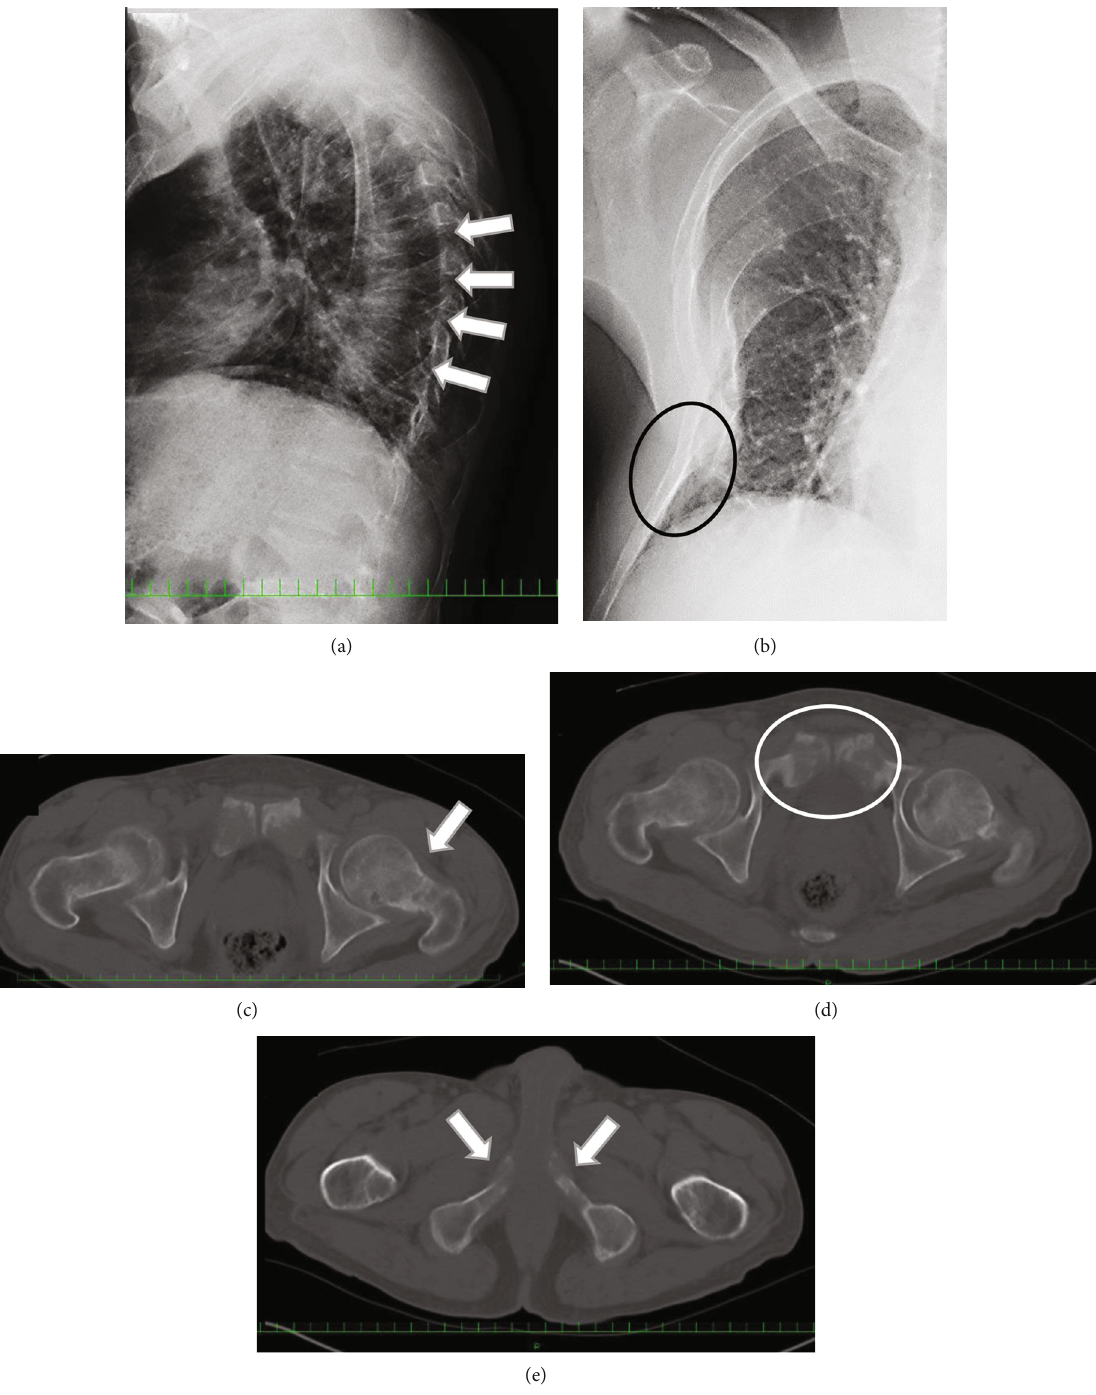
Figure 1: Radiographs taken in 2007 showing multiple vertebral fractures (a, white arrows) and right rib malunion (b, black circle). A left femoral neck insu ffi ciency fracture (c, white arrow) and deformity of both pubes (d, white circle) and ischia (e, white arrows) are shown in computed tomography images in